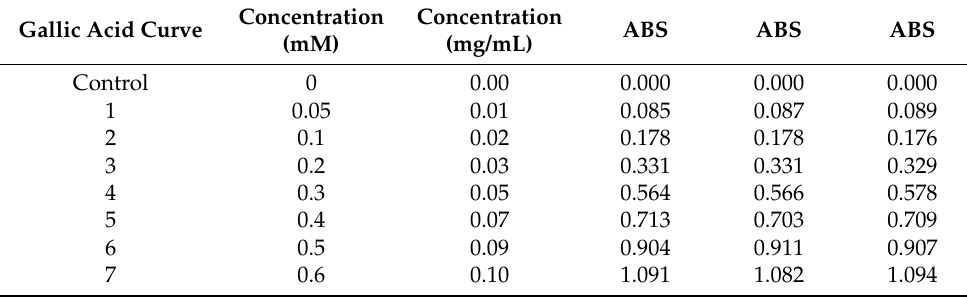
Table 3. Ratio of total phenolic compounds (TPC) determined by the Folin – Ciocalteu method. SD: standard deviation. For each column different superscript letters (a and b) mean statistically sig- nificant variations among samples.